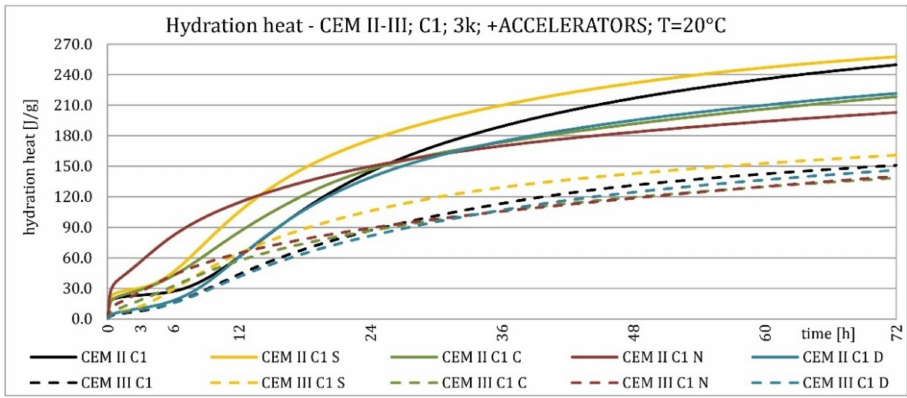
Figure 21. Hydration heat of C1 clinker-based cements CEM II/B-S, CEM III/A modified with accelerators at 20 ◦